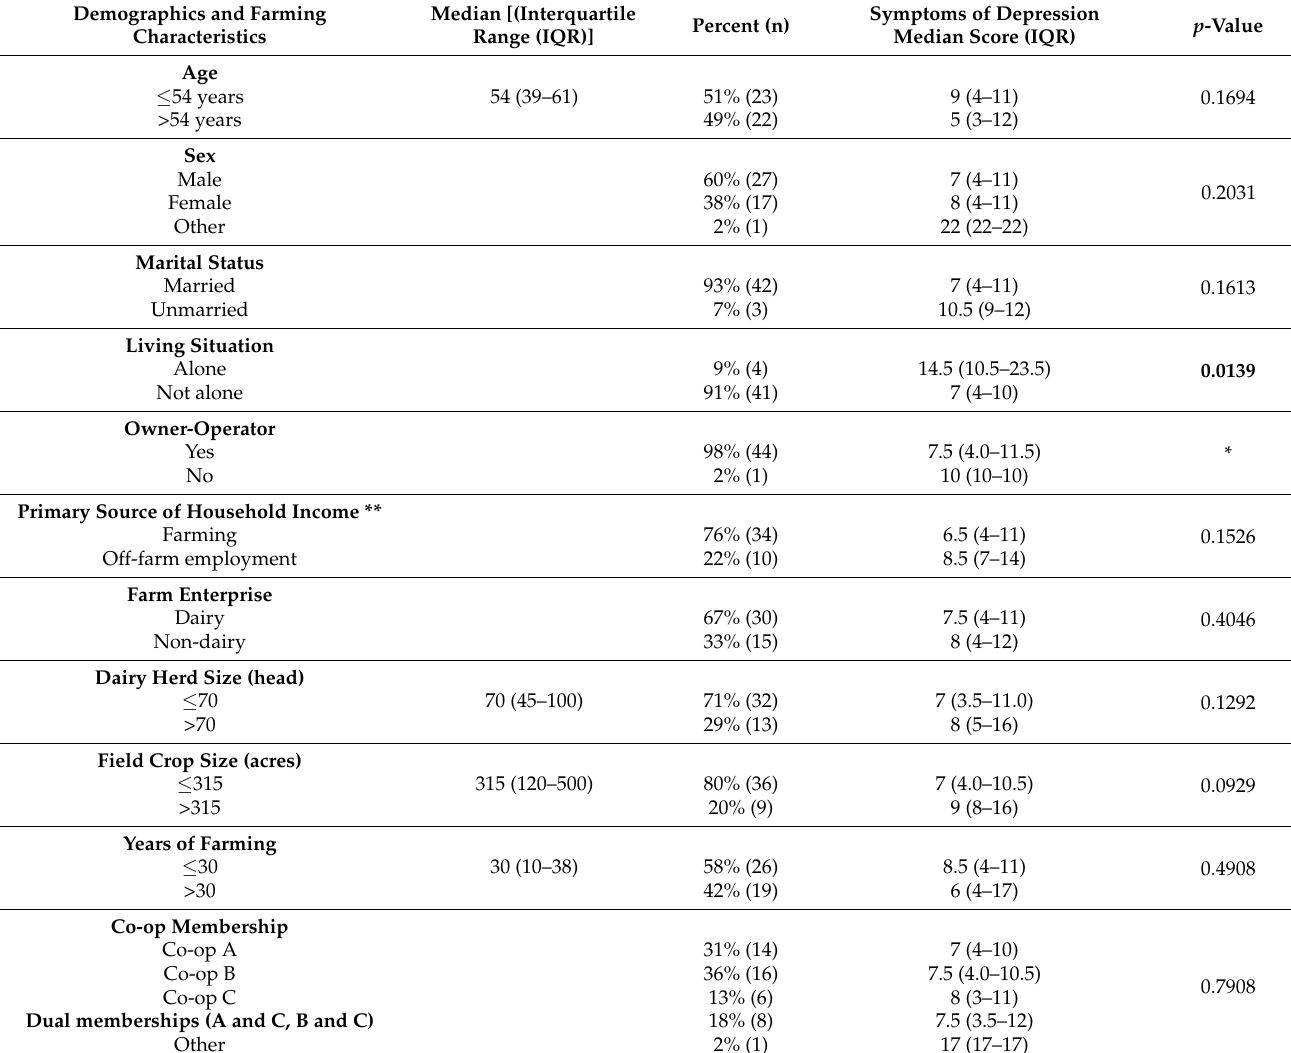
Table 2. Demographics and farming